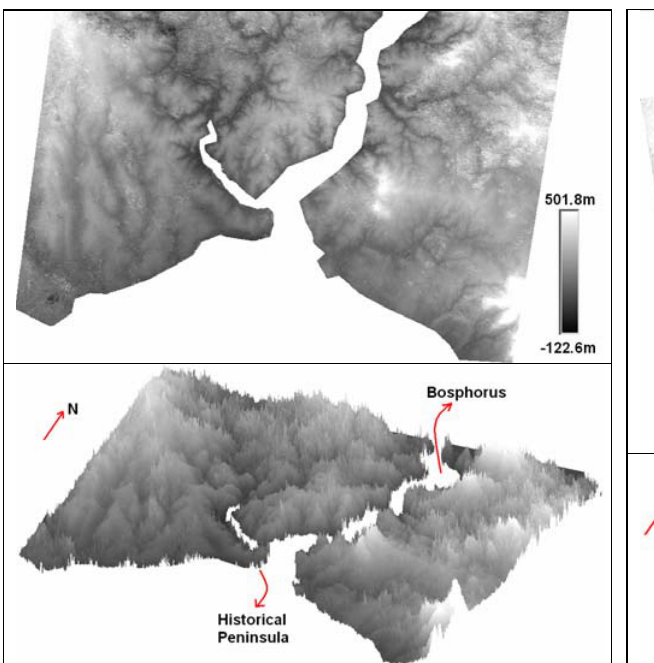
Figure 9.a. DEM of TSX SM InSAR data set and 3D visualization (10 m grid spacing, 10 – Z exaggeration factor)